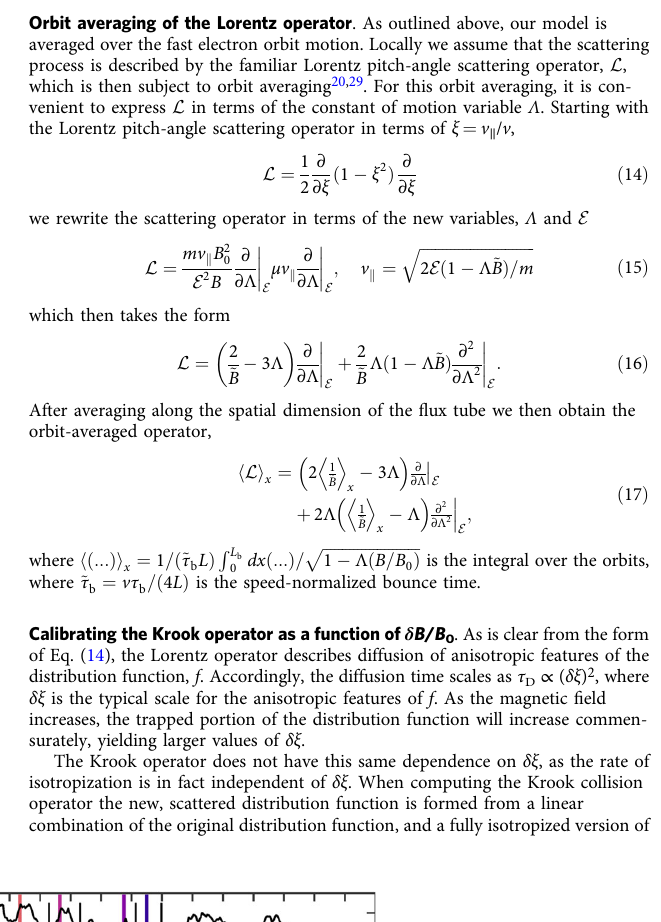
tions from the theory.